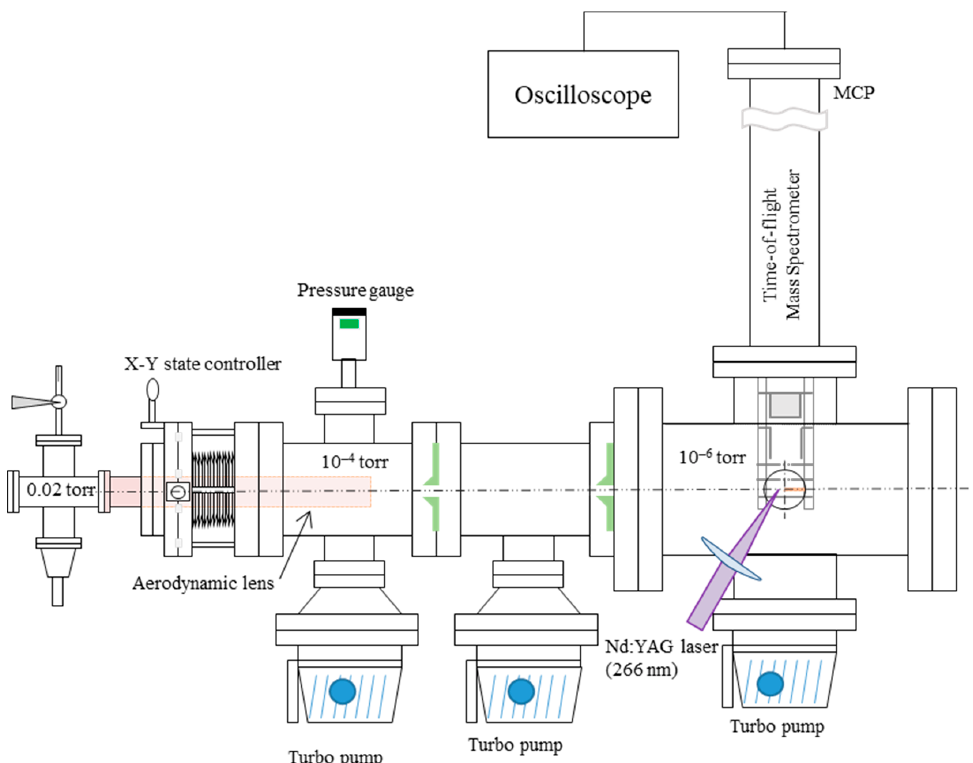
Figure 1. A schematic of the single-particle mass spectrometer. A Nd: YAG laser (Ultra50, Quantel, Bozeman, MT, USA) with a 266 nm wavelength